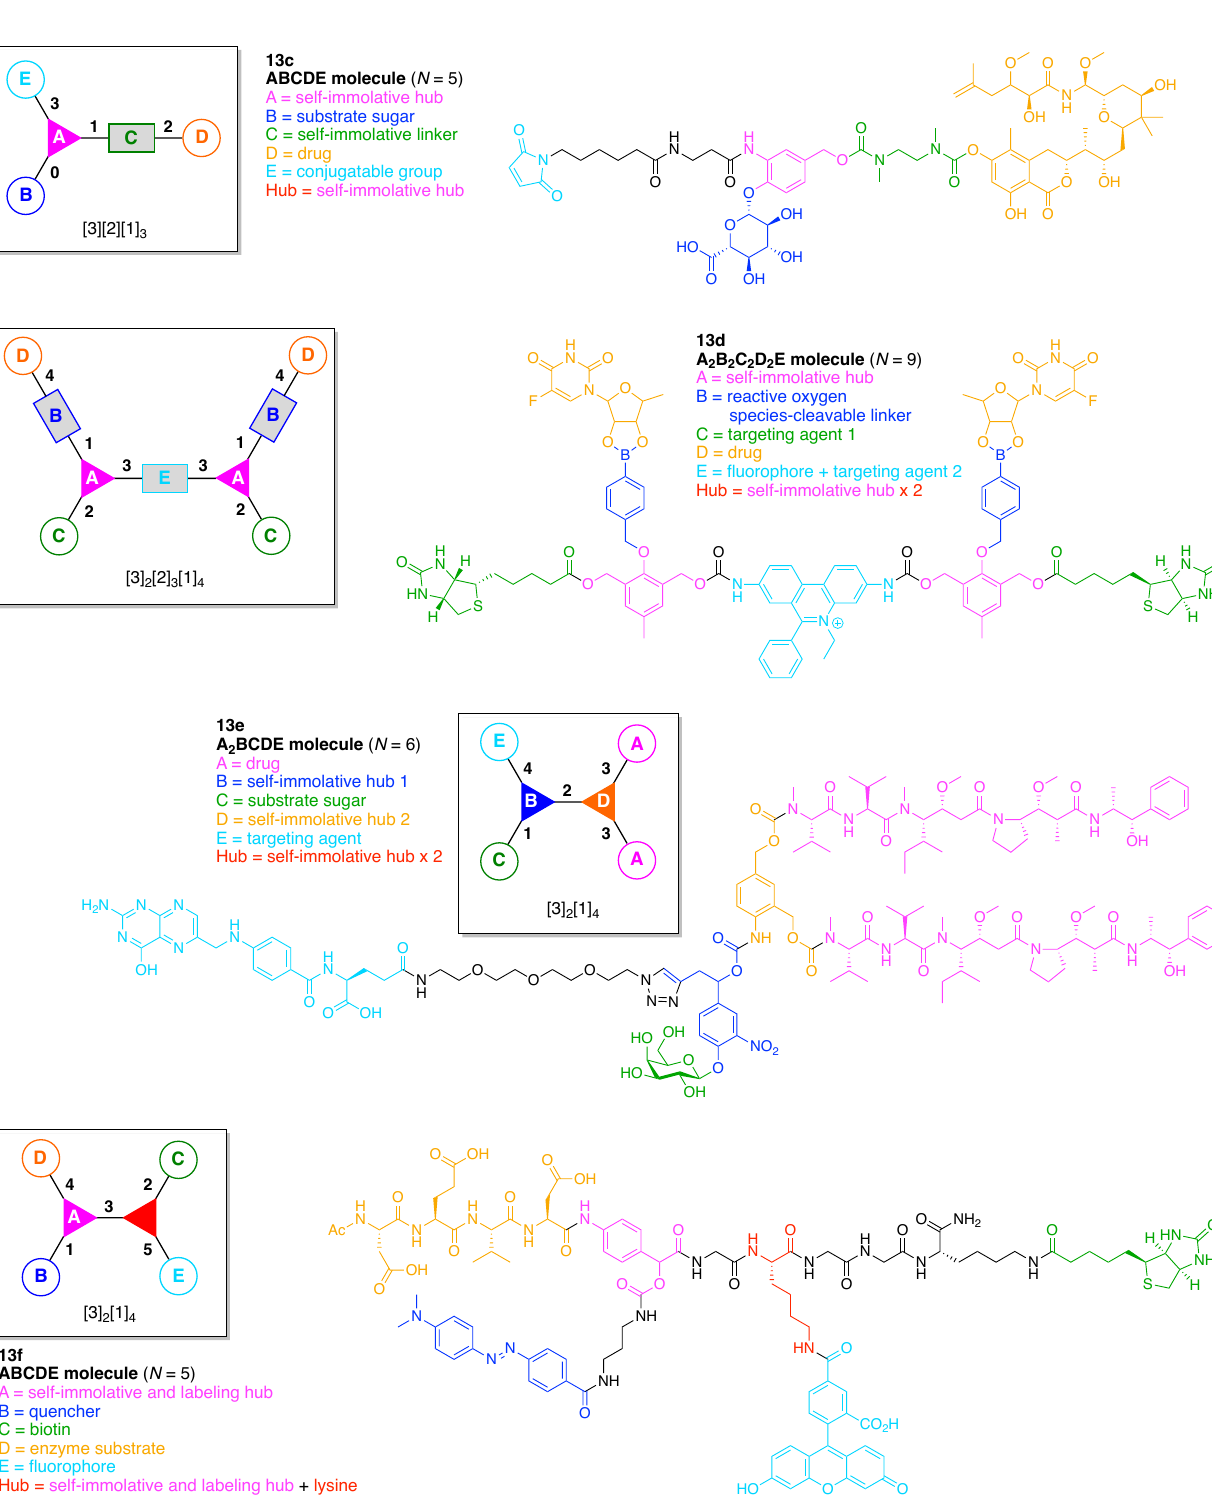
Figure 64. Four examples each containing a self-immolative hub. Alsarraf et al. synthesized a dendritic folate-drug conjugate ( 13e ) built around a combination of two self-immolative linkers (Figure 64) [309]. The folate-drug conjugate ( 13e ) is composed of two monomethylauristatin E (MMAE) as anti-tumor drugs (Unit A), two self-immolative hubs (Units B and D), galactose as an enzymatic-cleavable trigger (Unit C) and folate as a FR targeting agent (Unit E). This construct ( 13e ) has composition A 2 BCDE and architecture [3] 2 [1] 4 . This dendritic folate-drug conjugate can recognize the